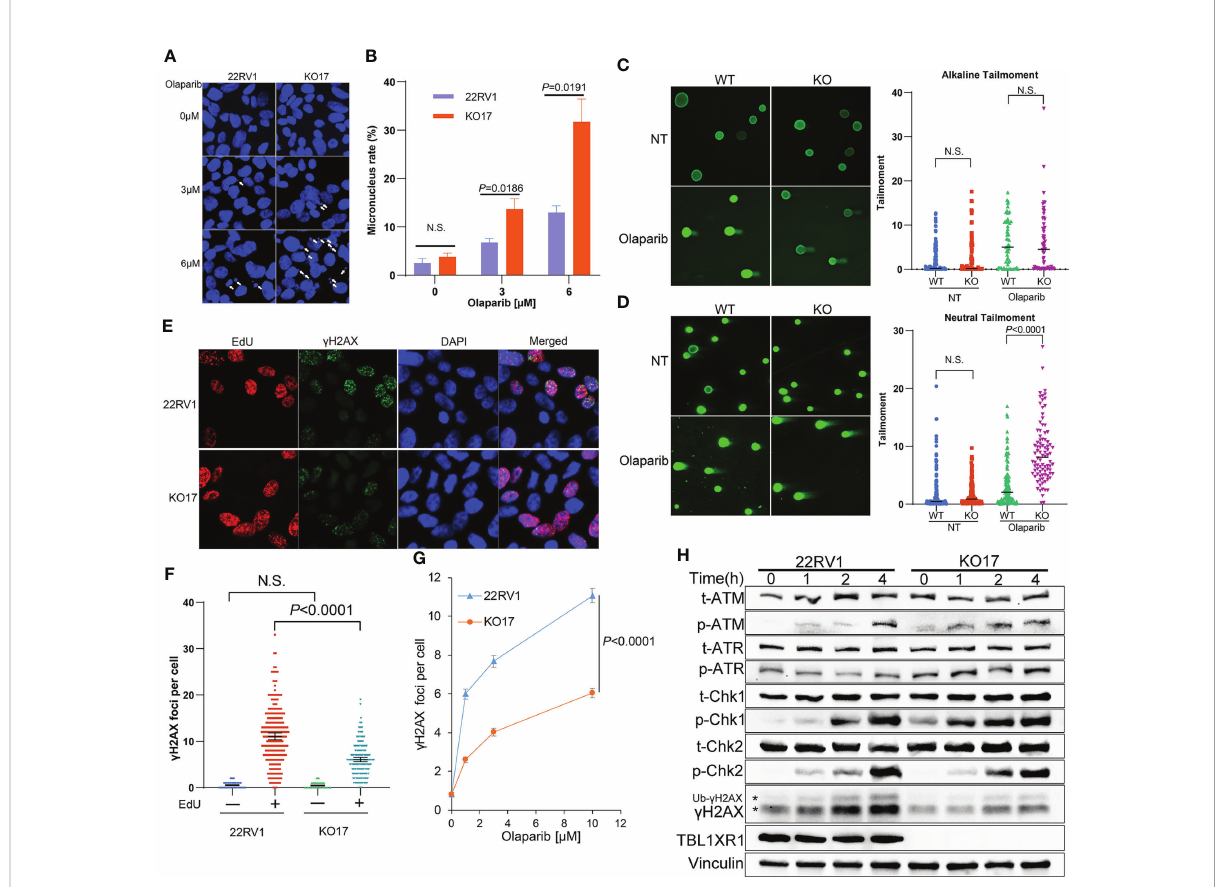
FIGURE 4 (A, B) Micronucleus rate of WT and TBL1XR1-de fi cient cells under 0 m M (vehicle), 3 m M or 6 m M olaparib treatment for 48h. Micronucleus rate was measured by micronuclei number/total cell nucleus number in one image fi eld (A) . 5 image fi elds were calculated for each experimental group (B) . P values calculated by two-tailed Student ’ s t-test. N.S. indicated not signi fi cant. (C, D) Comet assay of WT and TBL1XR1-de fi cient cells with or without olaparib treatment in alkaline condition (C) and neutral condition (D) . NT, no treatment. P values calculated by two-tailed Student ’ s t- test. N.S. indicated non-signi fi cant. (E – G) g H2AX foci in WT and TBL1XR1-de fi cient cells under olaparib treatment. Representative images of g H2AX foci and EdU staining in cells after 10 m M olaparib treated for 4h were shown in (E) . g H2AX foci number per cell in EdU negative